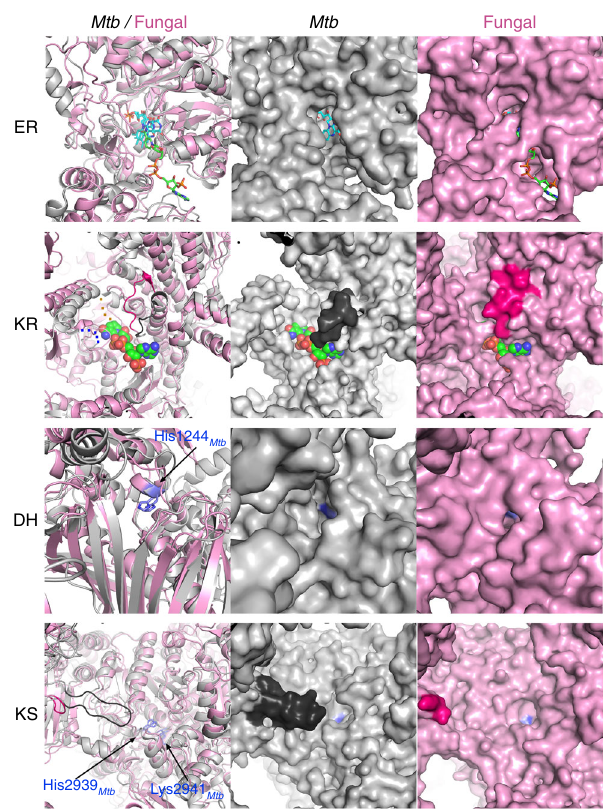
Fig. 4 Catalytic clefts of Mtb FAS-I structurally differ from fungal FAS-I. The four catalytic domains that take part in extension and modi fi cation of the growing aliphatic chain during fatty acid synthesis are shown using ribbon representation (left column). The polypeptide chains of Mtb FAS-I (gray) and of the fungal FAS-I (pink, PDB code: 4V59) are superimposed. Surface representations of Mtb FAS-I (middle column) and of fungal FAS-I (right column) illustrating the differences in shapes of the catalytic clefts between Mtb and fungal FAS-I. The enoyl reductase domains (ER, top row) are shown with the bound FMN co-factors in cyan. The fungal FAS-I structure was determined with a bound NADPH that is colored green. In the ketoacyl reductase domain (KR, second row from top) of Mtb FAS-I, two short loops were not visible in the density maps (blue and orange dots). NADPH from the structure of the fungal FAS-I is shown in green space- fi lling spheres. A loop that partially conceals the catalytic cleft in the fungal FAS-I (hot pink, residues 750 – 761) adopts a different structure in Mtb FAS-I (black, residues 2237 – 2248). The NADPH from the fungal FAS-I is shown in the surface representation of Mtb -KR to help visualize the catalytic cleft. The catalytic histidine residues of the dehydratase domains (DH, third row from top) are colored blue. The catalytic lysine and histidine residues of the ketoacyl synthase domains (KS, lower row) are colored blue. A long loop that projects from Mtb -KR toward the active site of Mtb -KS is shown in black. The corresponding loop in the fungal FAS-I is colored in hot pink. For better 3D perception, movies of the various catalytic modules are included (Supplementary Movies 1, 2, 3, 4, 5, 6, 7 and